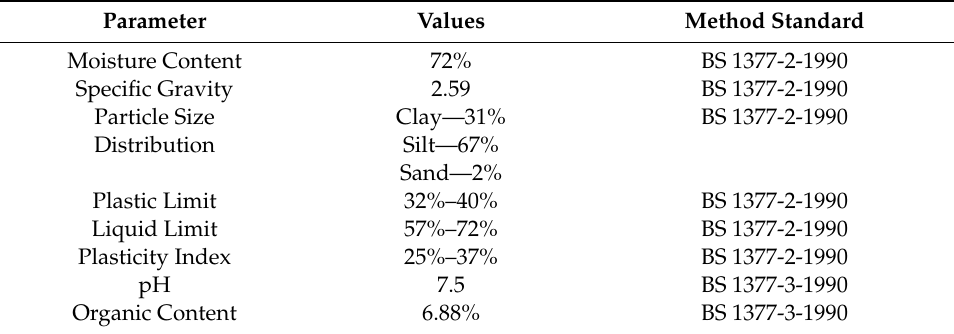
Table 1. Physical properties of marine clay soil.